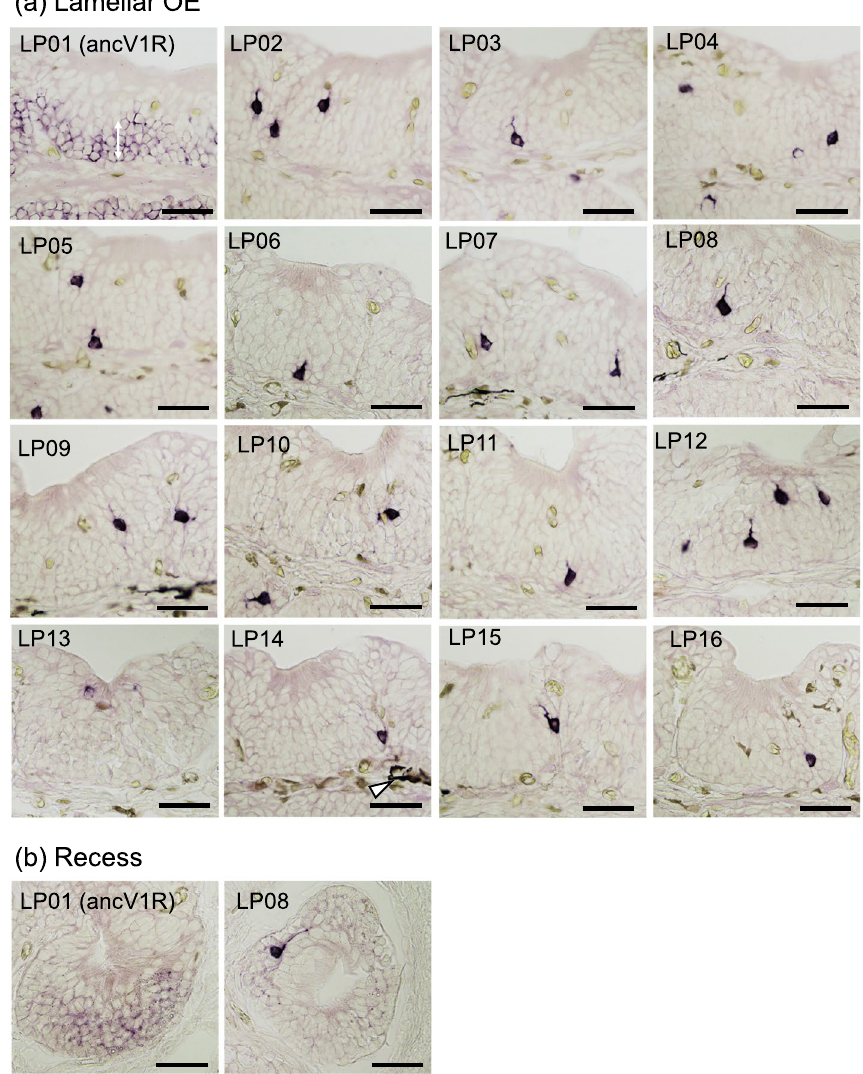
Fig. 6 V1R expression in the lamellar OE ( a ) and recess ( b ) of L. paradoxa . a Signals for ancV1R in the basal to middle layer of the lamellar OE (double-headed arrow in LP01) and punctate signals for the other V1Rs (LP02–LP16) in the basal to middle layer of the lamellar OE. Black spots around the epithelium (for example, arrowhead in LP14) are melanophore aggregations. b Signals for ancV1R in most ORCs of the RecE and a signal for LP08 in the RecE. Scale bars: 100